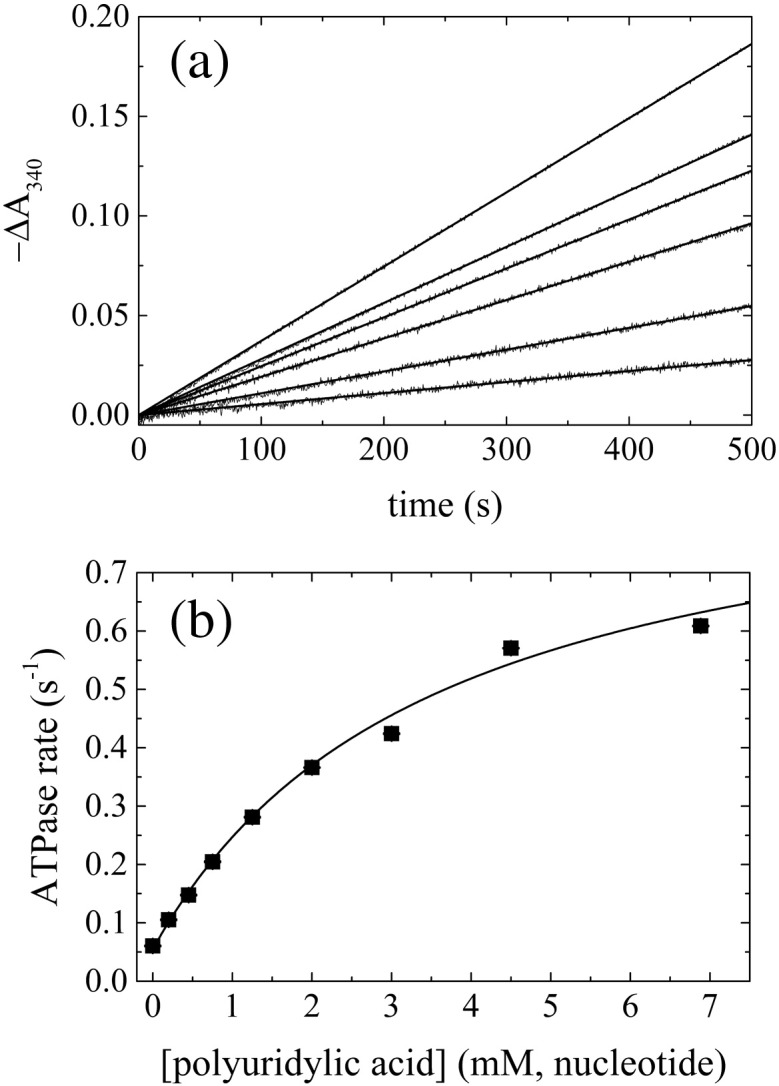
RNA-stimulated steady-state ATPase activity of Dbp5. Time courses of absorbance change at 340 nm assayed with the NADH-coupled assay after mixing 100 nM Dbp5 and 20 mM ATP with (lower to upper curves) 0, 0.45, 1.25, 2, 3, or 4.5 mM polyuridylic acid (concentration refers to total nucleotides). The continuous lines through the data represent the best fits to linear functions, yielding the steady-state ATPase rates from the slopes. (b) [ATP] dependence of the RNA-stimulated Dbp5 steady-state ATPase rate. The continuous line through the data represents the best fit to Eq. (11), yielding the maximum velocity per enzyme (kcat) from the amplitude and the KM,RNA from the [ATP] at half-maximum velocity (Table 1). Uncertainty bars represent standard errors in the fits and are within the data points.